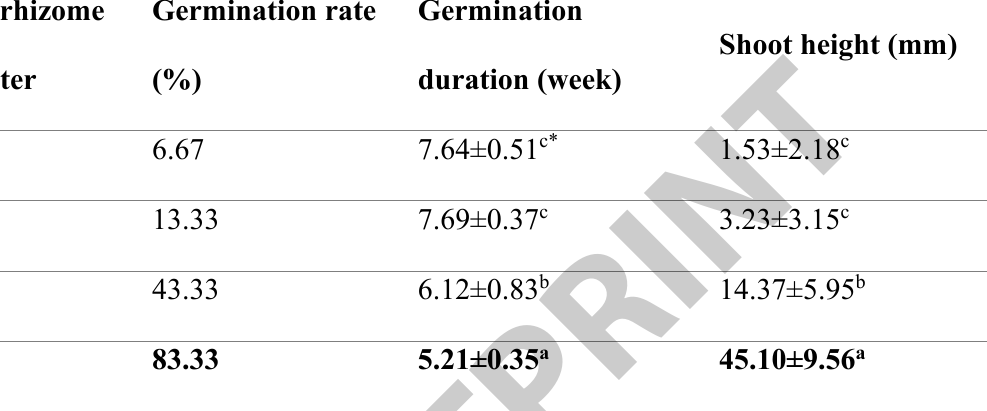
Table 10. Impacts of different microrhizome sizes on ex vitro regeneration